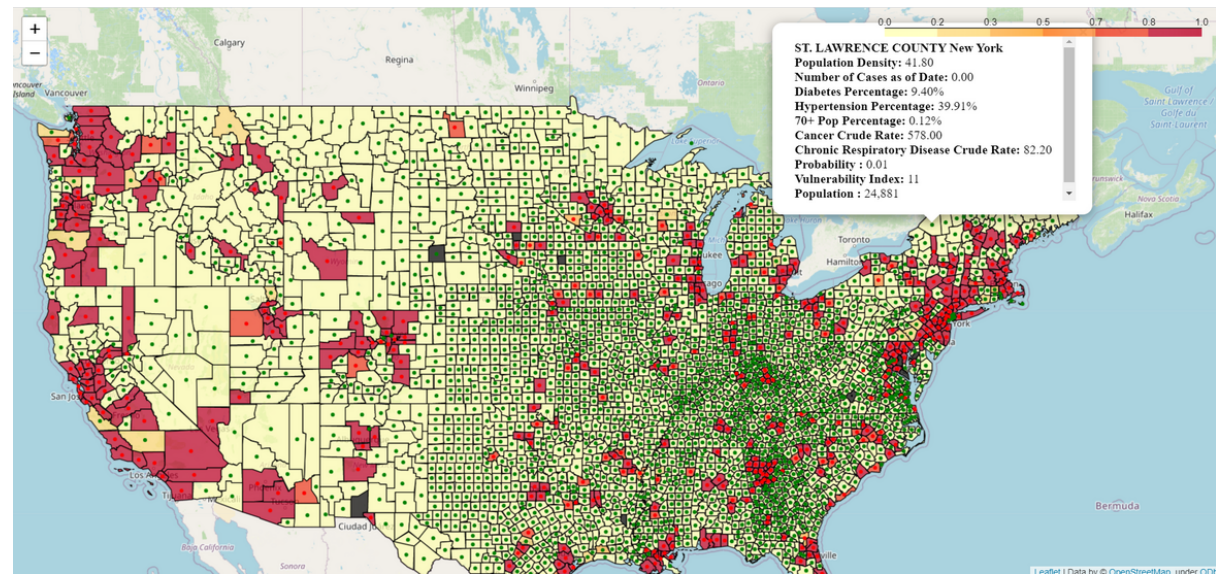
Figure 2. Predicted probability of there being a positive instance for each county in the United